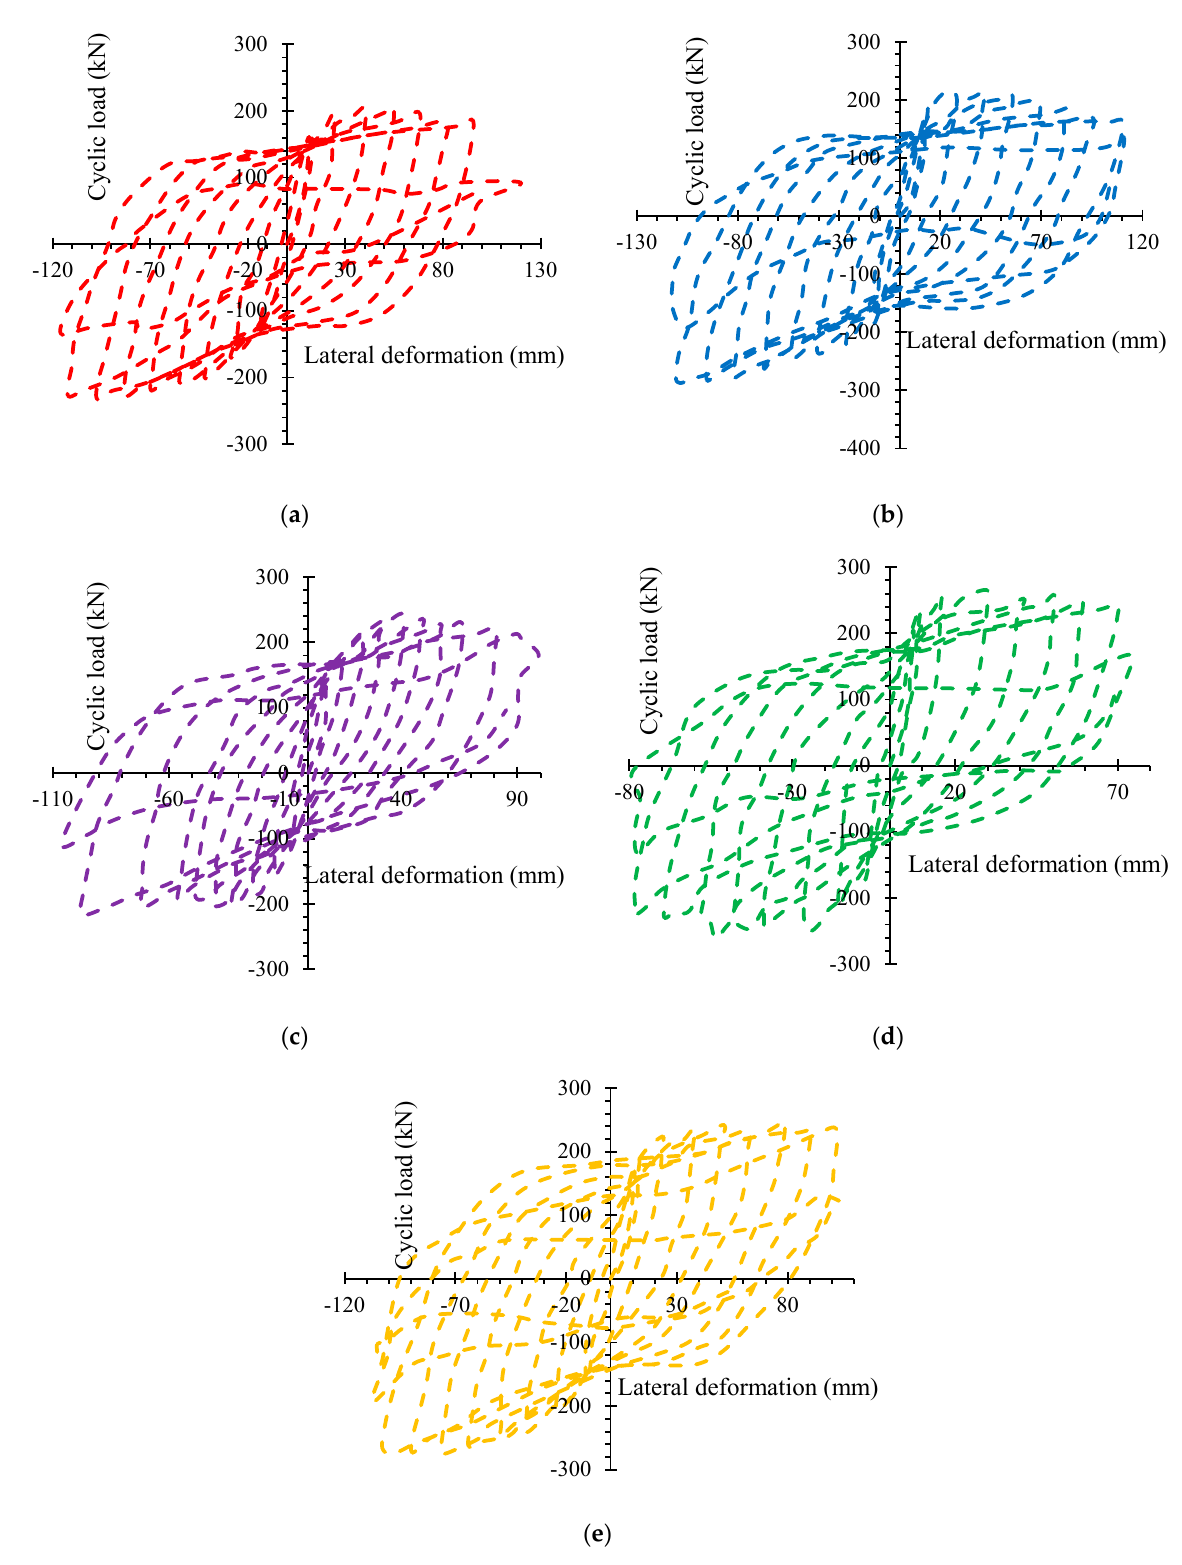
Figure 8. Transverse load-deformation curves of specimens: ( a ) RAGC0-0.2-STT8 ( b ) RAGC50-0.2- STT8 ( c ) RAGC100-0.2-STT8 ( d ) RAGC50-0.4-STT8 ( e ) RAGC50-0.2-STT10.